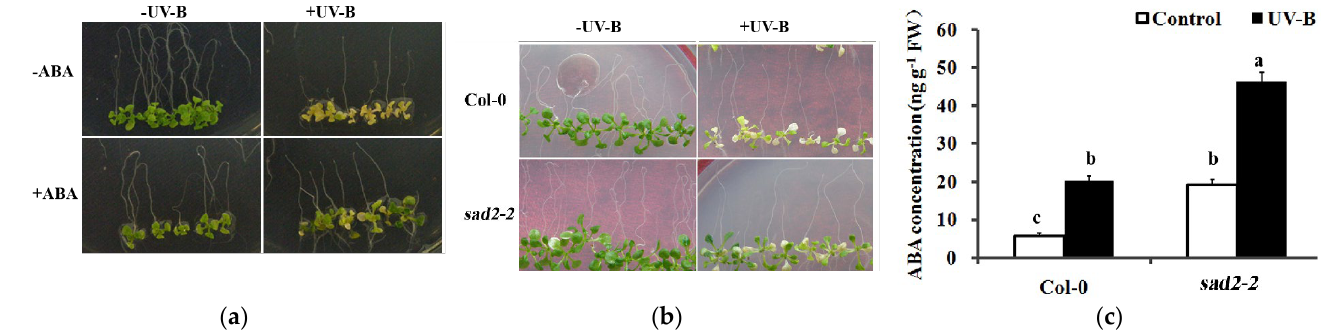
Figure 1. UV-B radiation increased endogenous ABA concentration in A. thaliana seedlings, and exogenous ABA supplementation protected seedlings from UV-B radiation. ( a ) Six-day-old wild-type (Col-0) seedlings vertically grown in MS medium with or without 0.5 µ mol L − 1 ABA were irradiated with 90 mJ cm − 2 of UV-B light for 30 min and positioned upside down. Phenotypes of the seedlings were photographed 6 days post-radiation; ( b ) Six-day-old wild type and sad2-2 mutant seedlings vertically grown in MS medium were irradiated with 90 mJ cm − 2 of UV-B light for 30 min and positioned upside down; ( c ) Endogenous ABA levels of six-day-old seedlings from wild type and sad2-2 mutants were assayed using a Plant Hormone ABA ELISA kit 60 min after radiation began and 30 min after it ended. Each experiment was repeated at least three times. All the statistical analyses were conducted using the IBM SPSS Statistics 27 software. All values are expressed as the mean ± SE ( n ≥ 20). Letters of a-c represent statistically significant groupings of p ≤ 0.05 based on a one-way ANOVA with the LSD multiple range tests.